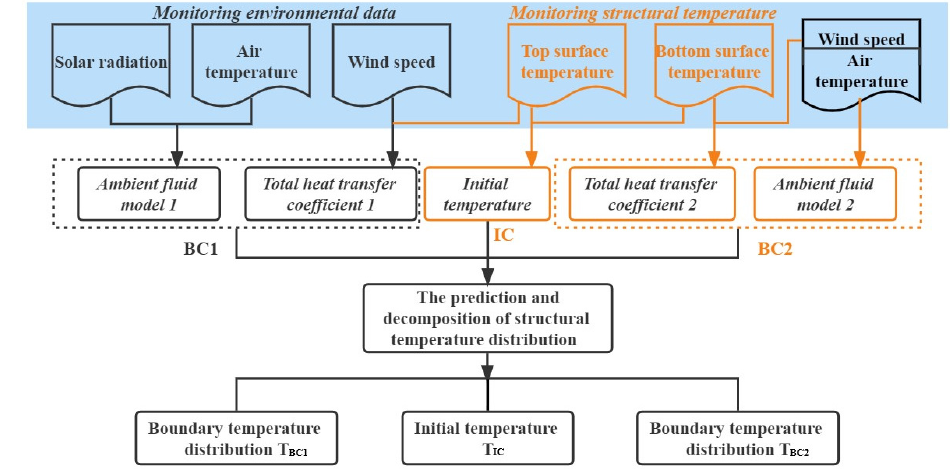
Figure 9. Flowchart of the analytical method using meteorological parameters.